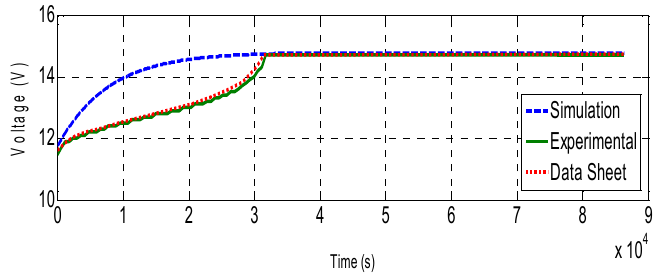
Figure 12. Charging voltage as the function of time.